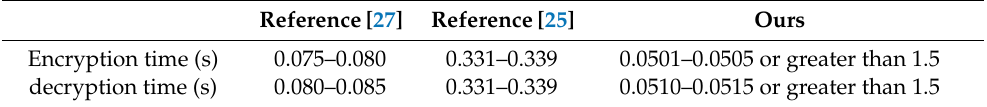
Table 5. Calculation speed